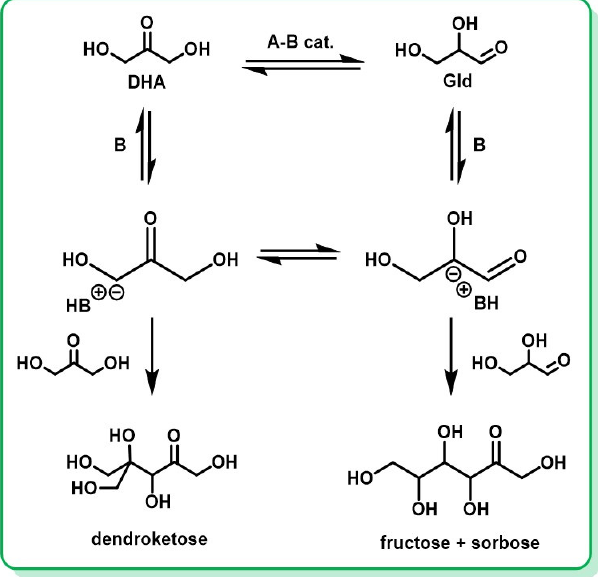
Figure 14. Reaction scheme of the base-catalyzed condensation of trioses. Adapted from [84].